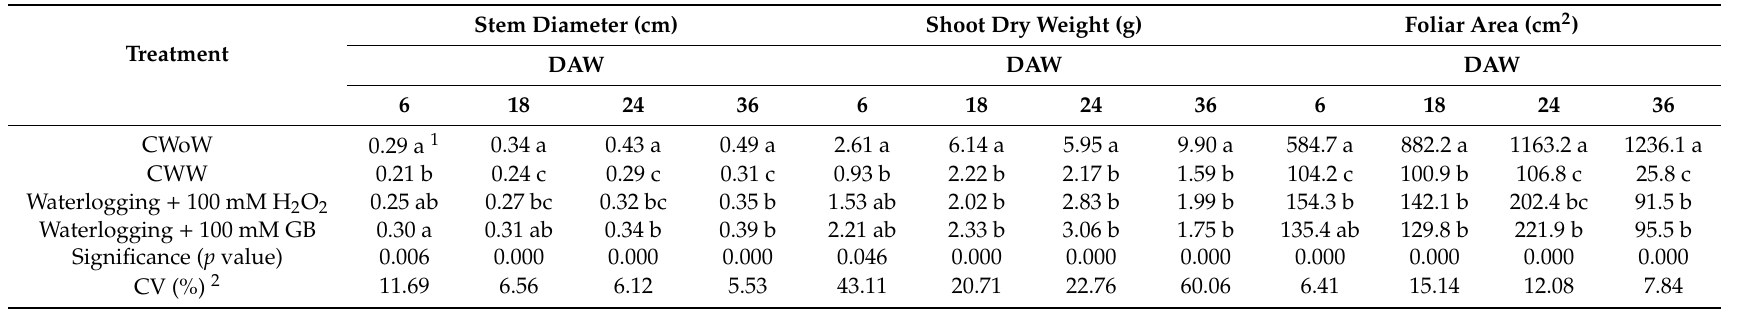
Table 3. Growth parameters (leaf area, shoot dry weight and stem diameter) of Cape gooseberry ( Physalis peruviana L.) plants ecotype Colombia subjected to two waterlogging periods with control treatments without waterlogging (CWoW), control with waterlogging (CWW), 100 mM of hydrogen peroxide (H 2 O 2 ) and 100 mM of glycine betaine (GB). Evaluated at 6, 18, 24, and 36 days after waterlogging (DAW).